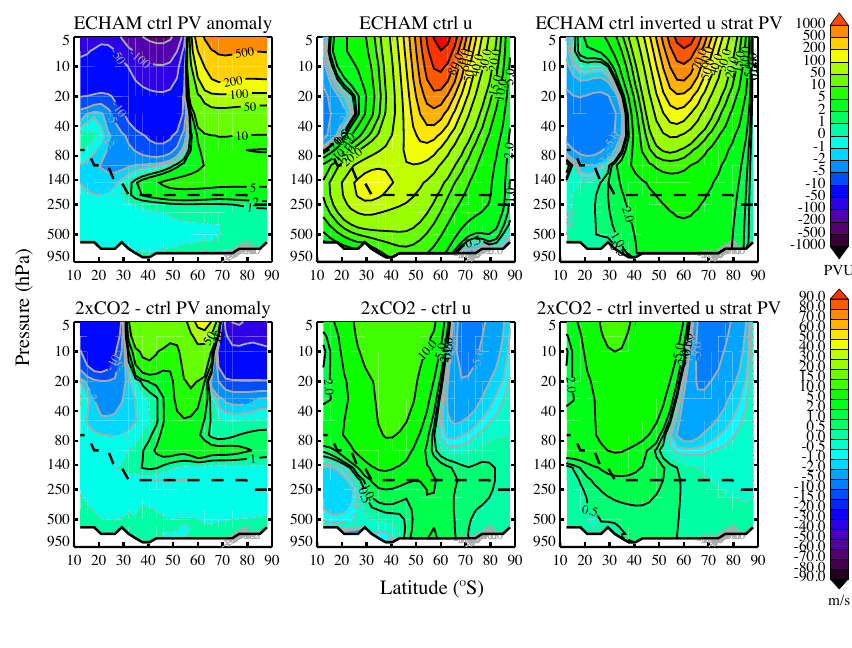
Fig. 8. Same as Fig. 6 but for August in the SH (minus the PV anomaly values are shown). Fig. 8. Same as Figure 6 but for August in the SH (minus the PV anomaly values are shown). order of magnitude as the total response in model zonal wind (lower middle panel in Fig. 5). This indicates that the influ- ence of the stratosphere is relevant for the tropospheric re- sponse, and that it results in a weaker westerly wind in the high latitude troposphere in the NH 30